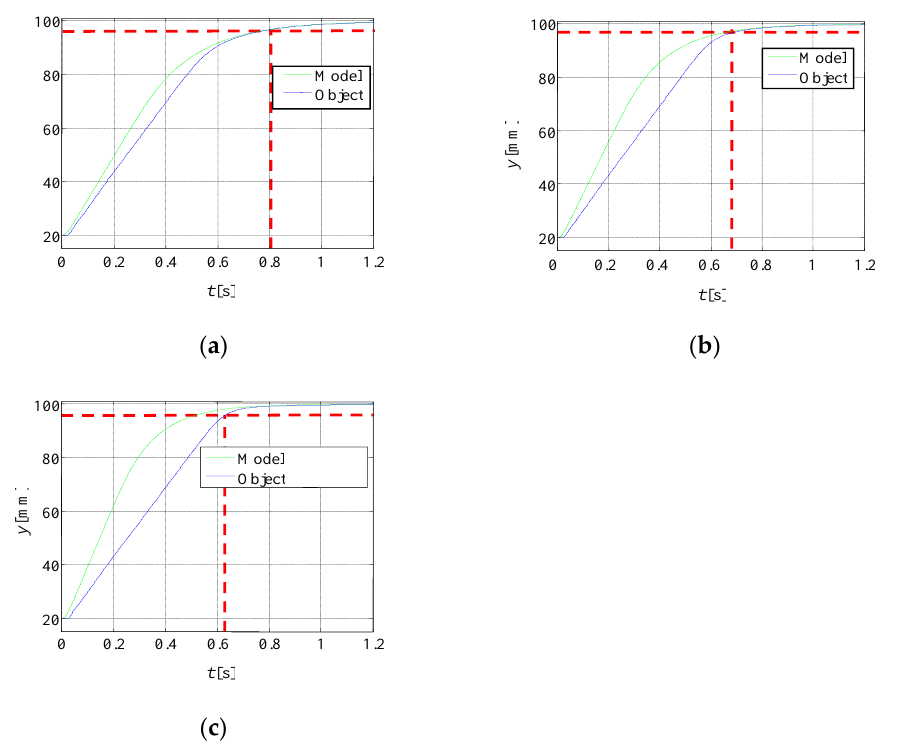
Figure 18. Positioning of MFC regulator and EHSD model for different parameters of the model coefficient K Q ( p 0 = 4 MPa, F = 697 N): ( a ) k q_k = 1; ( b ) k q_k = 1.5; ( c ) k q_k = 2.